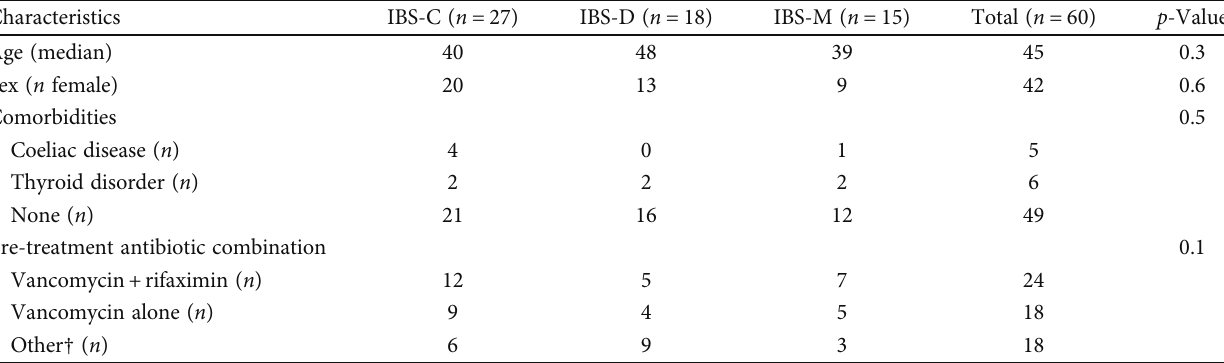
Table 2: Baseline demographics of the participants.